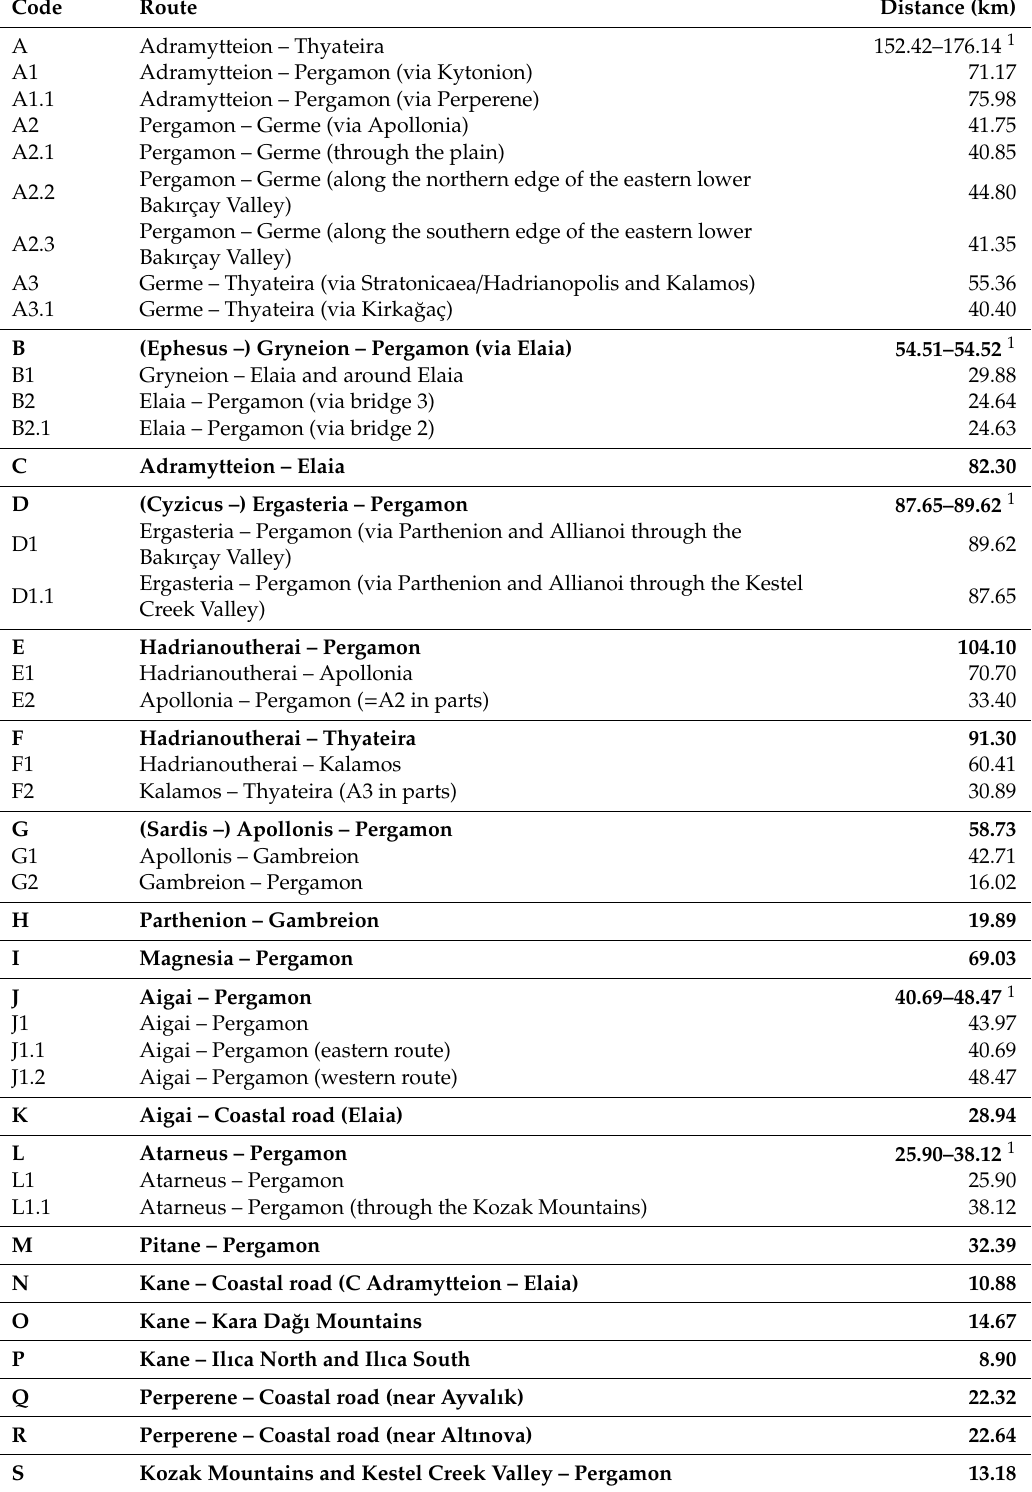
Table 4. Reconstructed routes with their code and